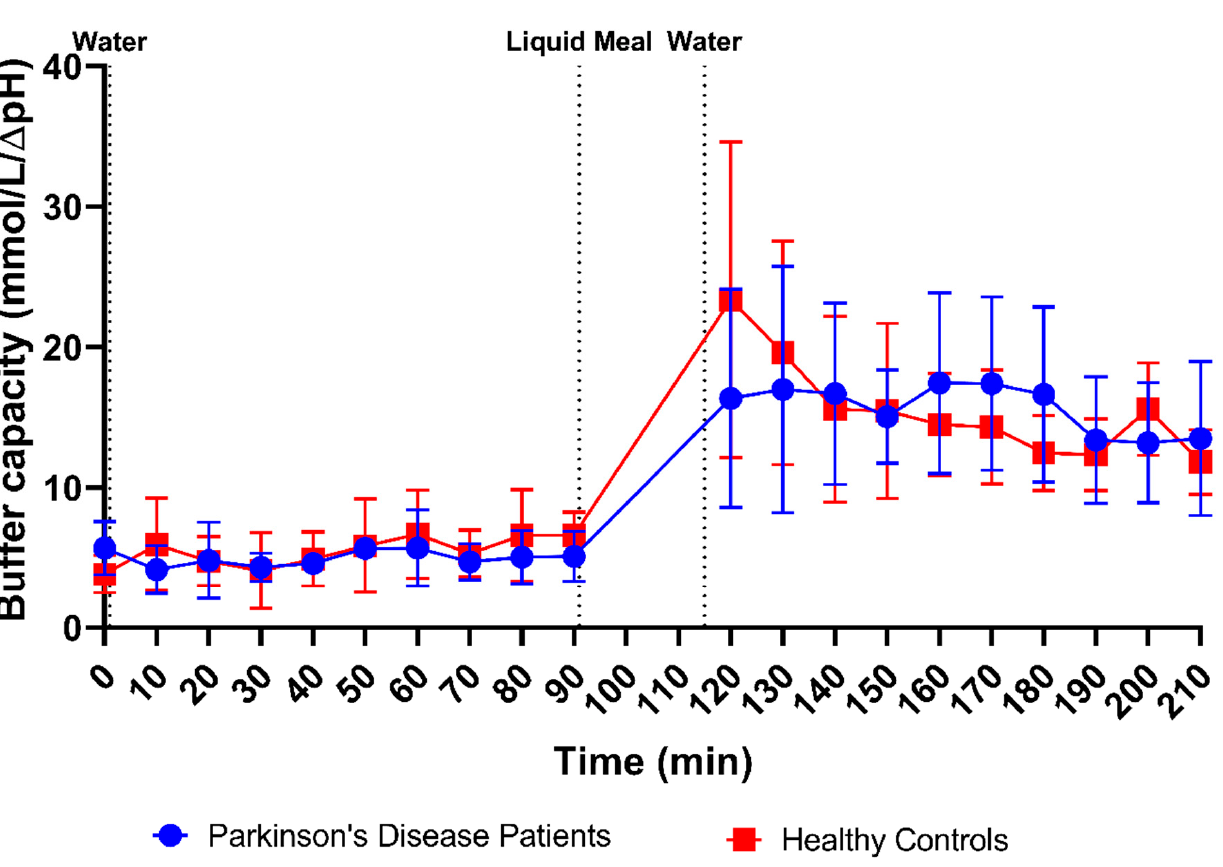
Figure 5. Time-dependent evolution of the buffer capacity in duodenal fluids aspirated from Parkinson’s disease patients ( n = 9, blue circles) and healthy controls ( n = 9, red squares). Data points represent the mean ± standard deviation; vertical dotted lines indicate the ingestion of 100 mL of water or 200 mL of liquid meal.